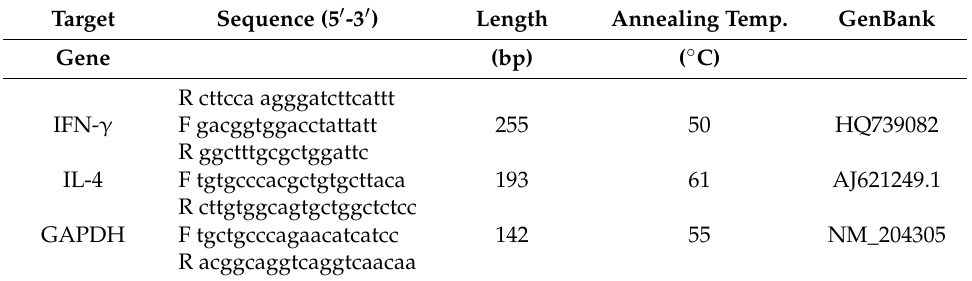
Table 3. Primers for cytokine